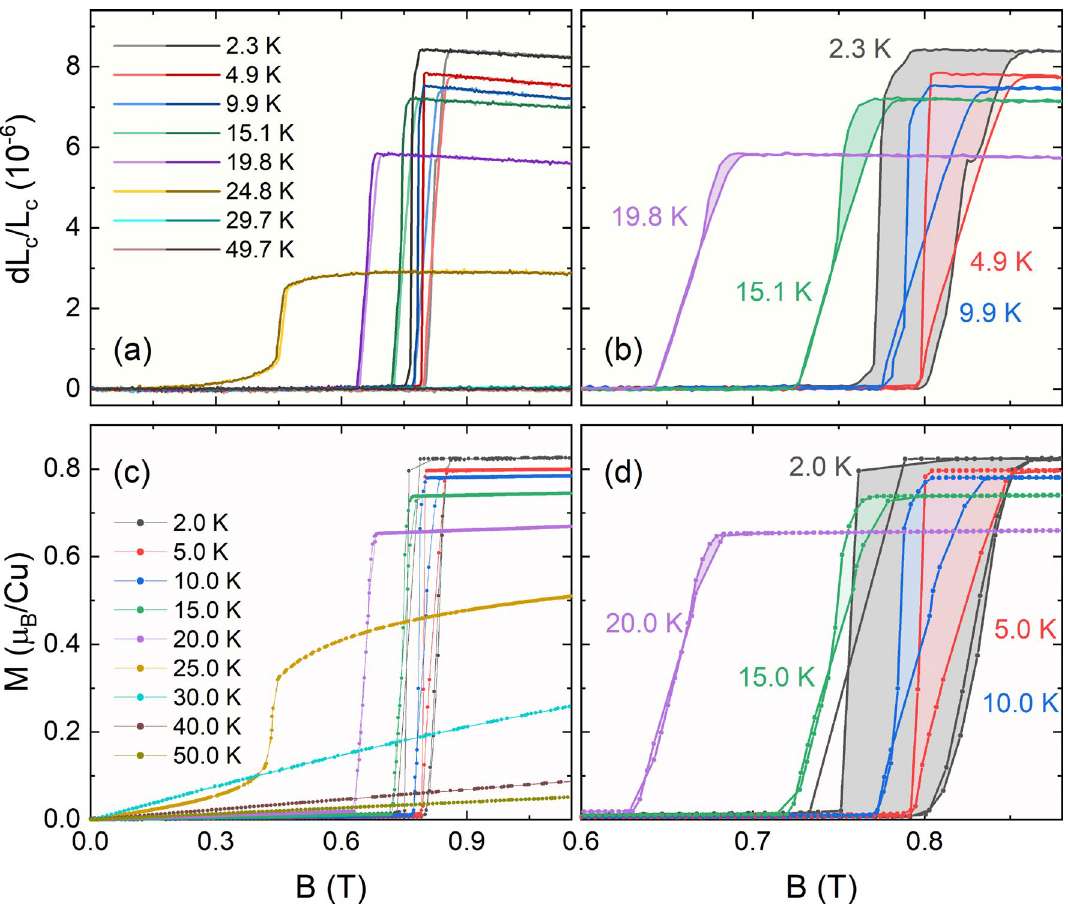
Figure 4. Linear magnetoelastic coupling: Magnetostriction and magnetization. Comparison of relative length changes dL c ( B )/ L c ( 0 ) ( a , b ) and isothermal magnetization ( c , d ) for B (cid:31) c . Note that ( b ) and ( d ) show a magnification of the transition region and only data for selected temperatures. Hysteresis is marked by colored areas. Magnetostriction down-sweeps in ( b ) are shifted by 6 mT to correct for the remanent field of the magnet.